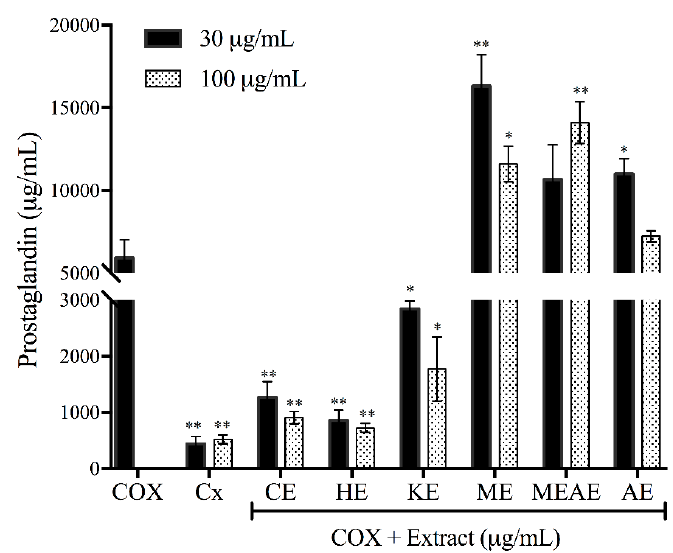
Figure 8. Effect of different Acacia farnesiana extracts on prostaglandin production. Cx = Celecoxib; CE = chloroformic extract; HE = hexanic extract; KE = ketonic extract; ME = methanolic extract; MEAE = methanolic:aqueous extract and AE = aqueous extract. The data are the mean with the standard deviation of three independent repetitions. Statistical difference was calculated in relation to COX at 30 and 100 ppm. * p < 0.05. ** p < 0.001.